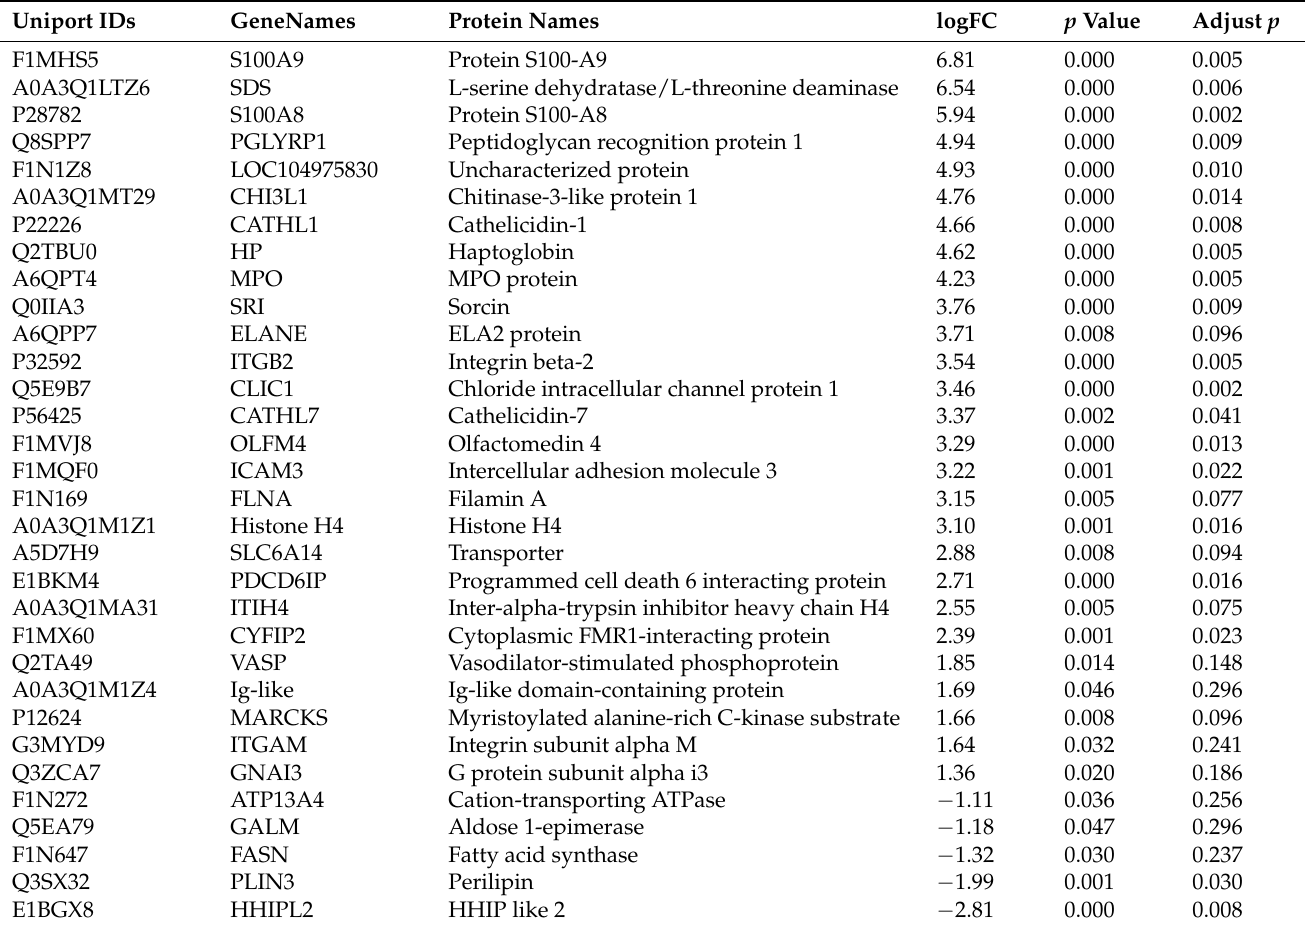
Table 1. Statistic analysis of the selected proteins in milk-derived EVs between the CM and Healthy group by moderated t -test. Log FC, Fold change calculated as CM/Healthy and expressed on a log2 scale. Adjust p , corrected by the Benjamini–Hochberg